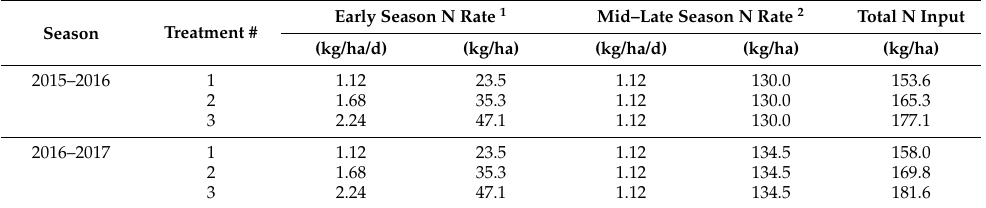
Table 1. Nitrogen (N) fertilization treatments tested for ‘Florida Radiance’ strawberry in